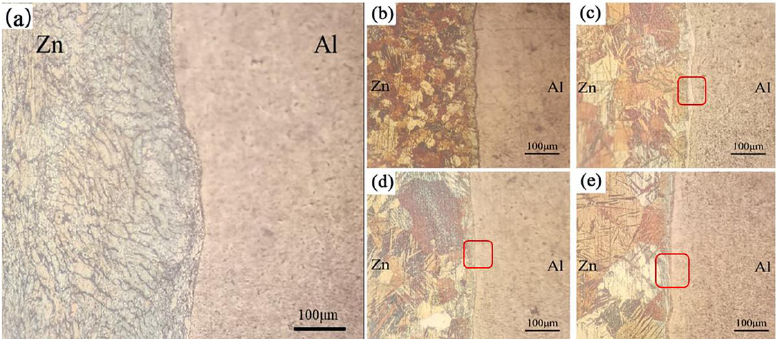
Figure 3. OM images of the samples under different annealing conditions, ( a ) rolled state; ( b ) 200 °C  1.5 h; ( c ) 240 °C  1.5 h; ( d ) 280 °C  1.5 h; ( e ) 320 °C  1.5 h. The red mark represents the interface zone.